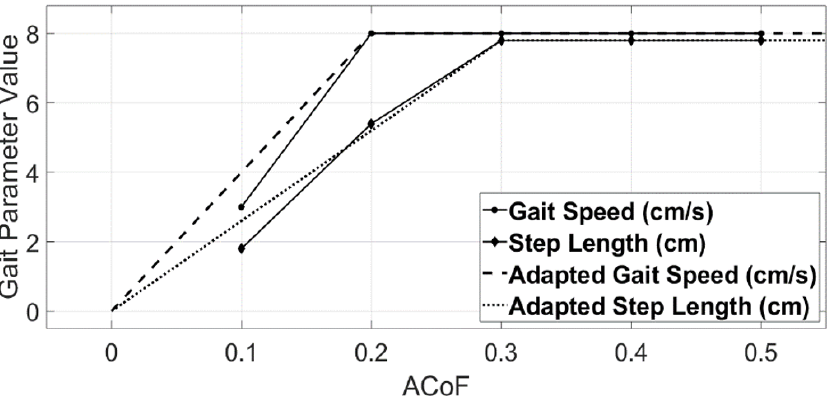
Figure 11. Adapted gait parameters that maximize walking speed and minimize slipping probability. Above an ACoF threshold of 0.3 the robot can walk safely at maximum speed and step length. The dotted lines represent the linear approximation between the maximum slip-free values obtained from simulation and gait step length and speed equal to zero, when the ACoF is zero as